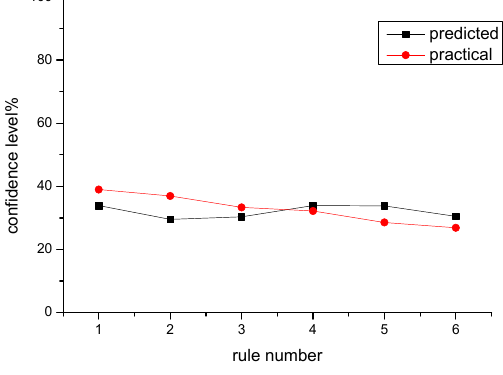
Figure 11. The comparison of the results.